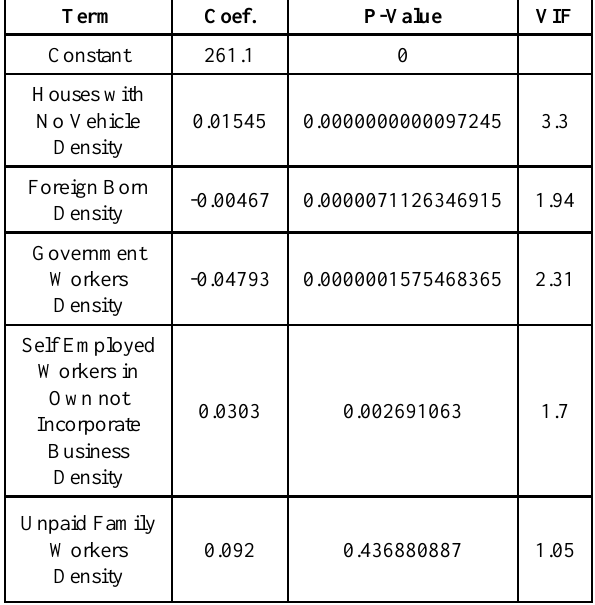
Table 2. Regression Results for JFK Airport Pick-up Location Driving Forces